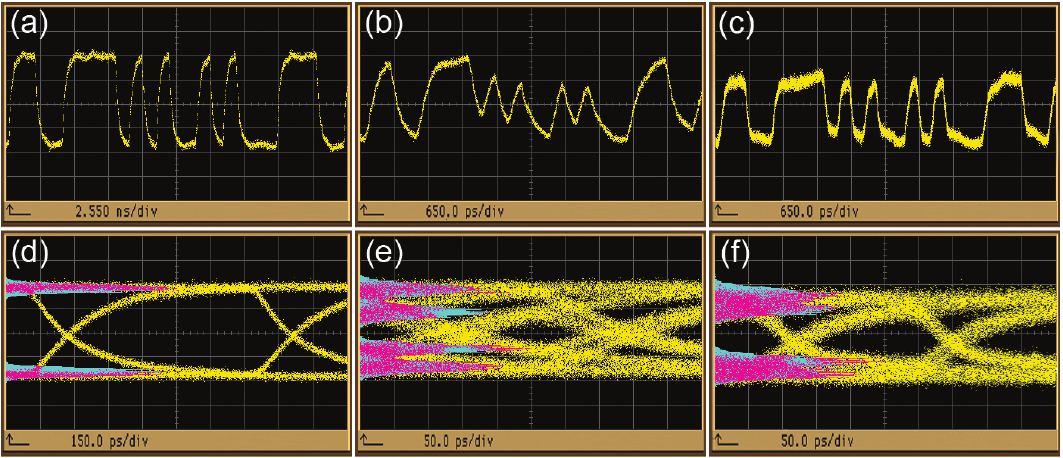
Figure 12. Top: Encoded pulse waveforms of ( a ) RSOA output at 1 Gb/s, ( b ) RSOA output at 4 Gb/s, ( c ) BFL output at 4 Gb/s for BFL detuning ∆ λ = − 0.05 nm. Bottom: Corresponding eye diagrams ( d – f ). Vertical scale: 15